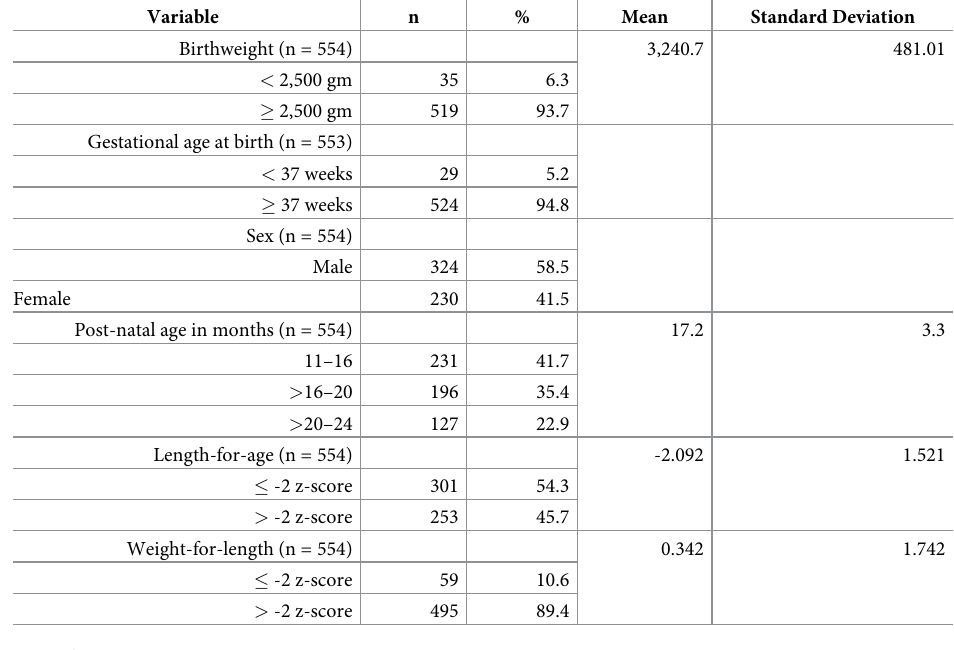
Table 3. Child characteristics at birth and 11–24 months after birth, Adami Tullu district,